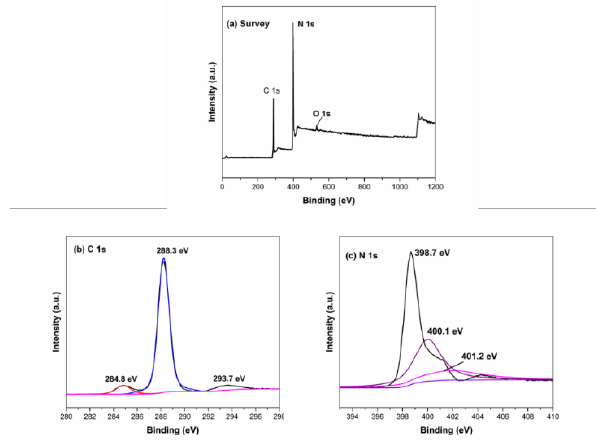
Figure 10. XPS spectrum of g-C 3 N 4 : (a) survey, (b) C 1s and (c) N 1s.